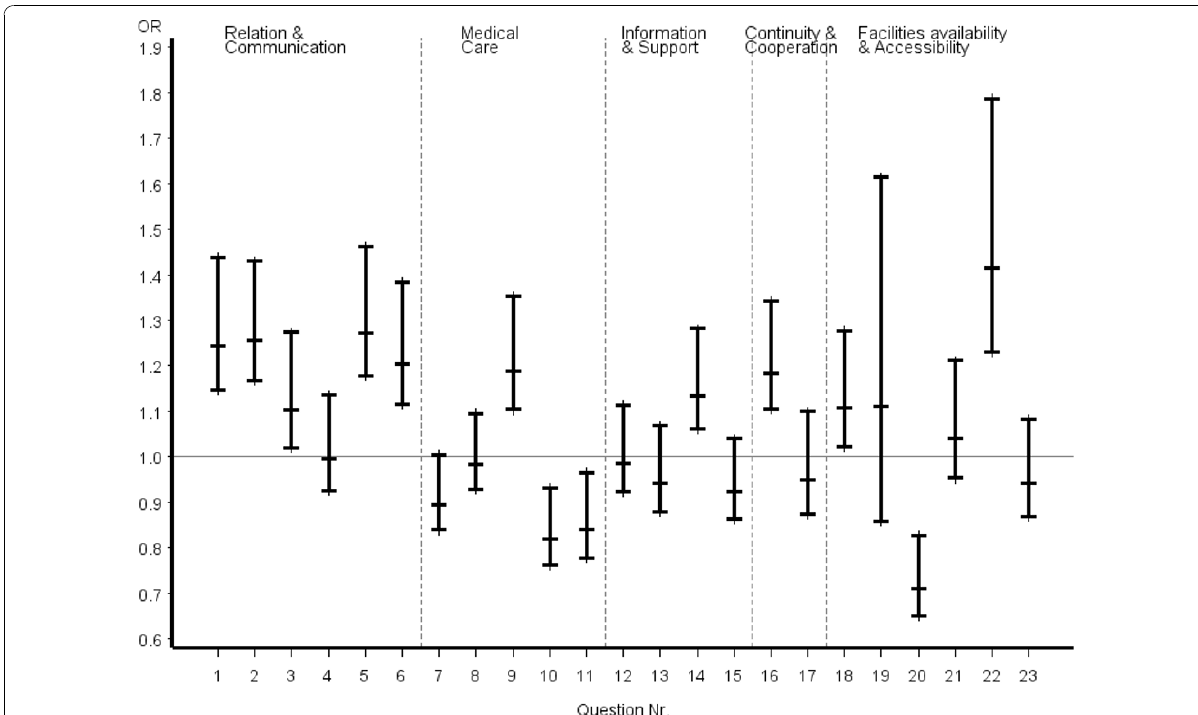
Figure 1 ..Europep questionnaire, odds ratios of most favourable answer option (certified CAM vs. COM) all patients . Errorbars denote 95% confidence intervals of odds ratios